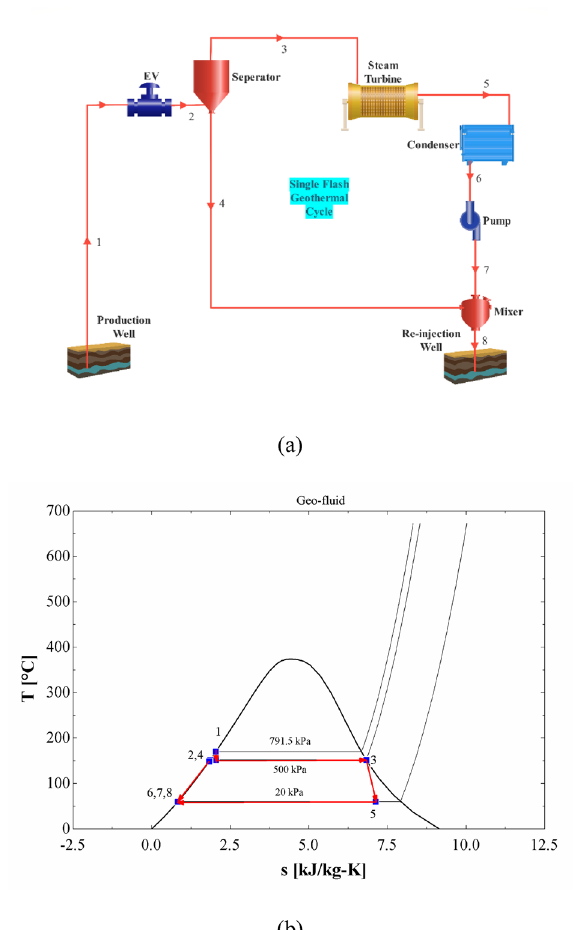
Fig. 2 a Schematic b T-s diagram of basic single flash geothermal power